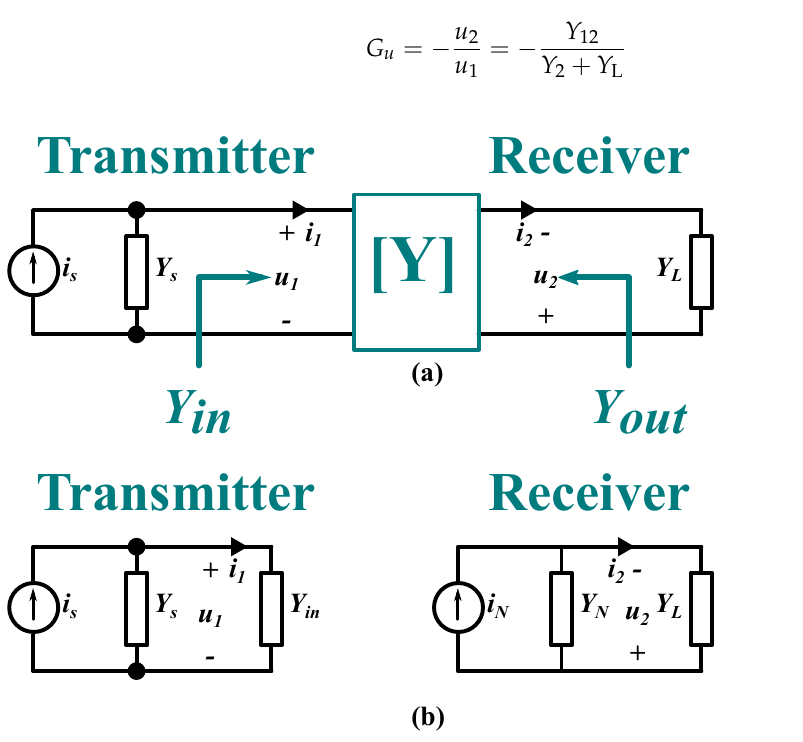
Figure 2. A general representation of CPT system: ( a ) two-port network connected to source and load. ( b ) The transmitter and receiver are equivalent